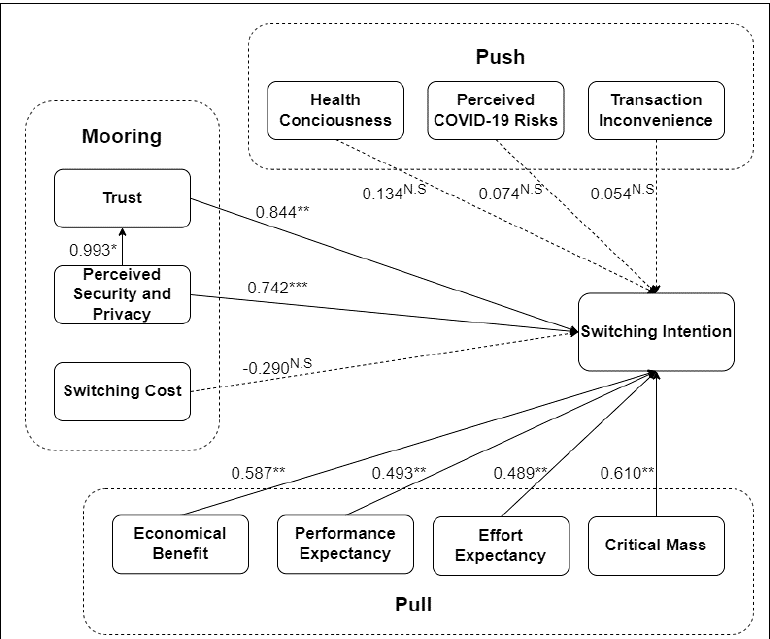
Figure 4. SEM results. Notes: *p < 0.05; **p < 0.01; ***p < 0.001; N.S: not significant. Fit indices: CMIN/df = 1.585; RMR = 0.028; GFI = 0.901; AGFI = 0.879; NFI = 0.935; TLI = 0.932; CFI = 0.969; PRATIO = 0.973; RMSEA =